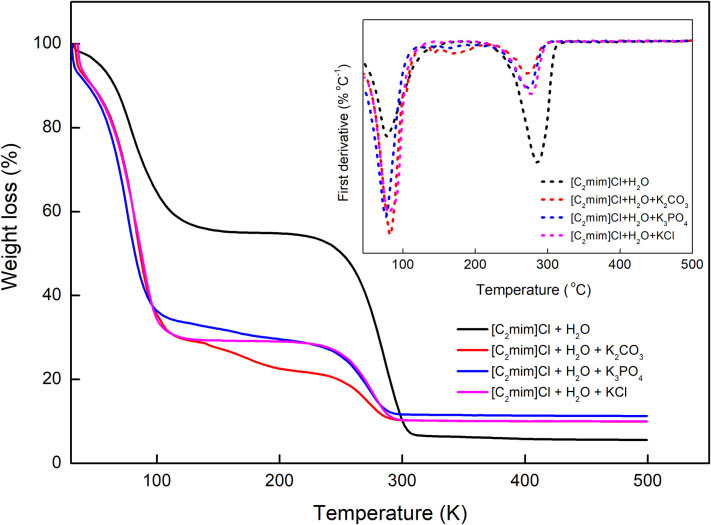
TGA and DTA curve of [C2mim]Cl + H2O and [C2mim]Cl + H2O + electrolyte.